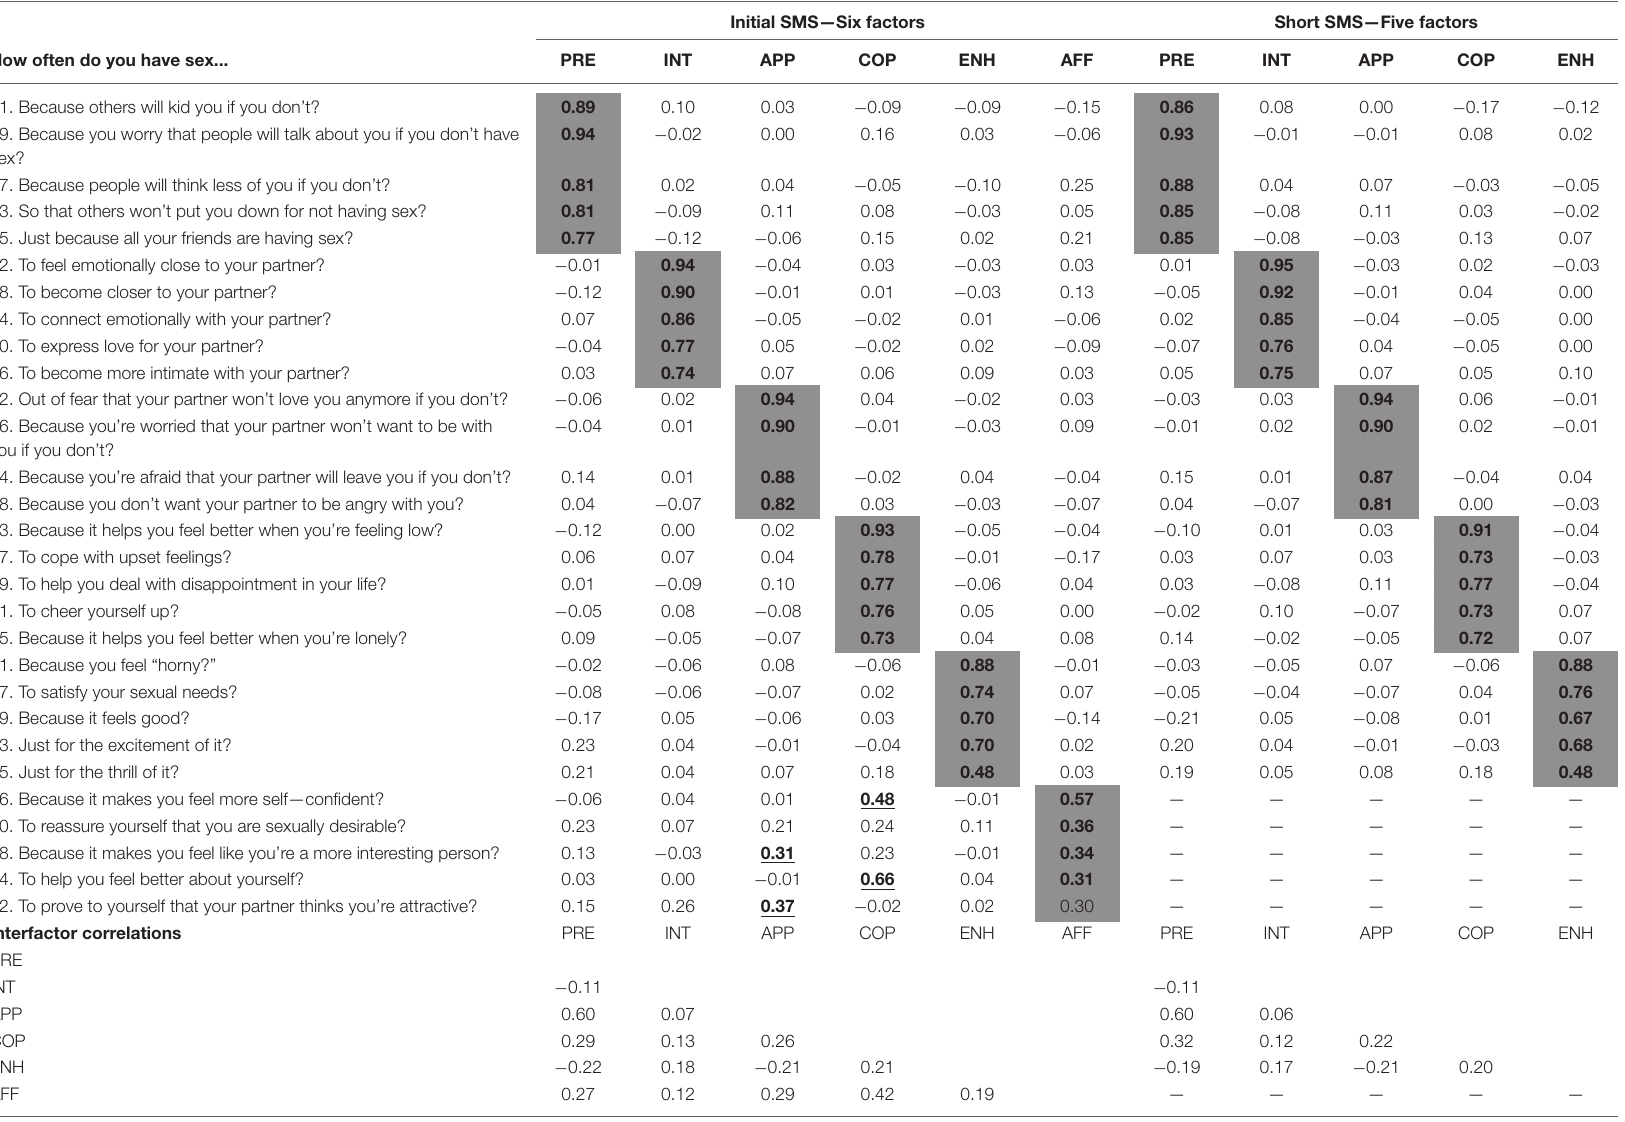
TABLE 2 | Item loadings and interfactor correlations for the Sexual Motivations Scale.